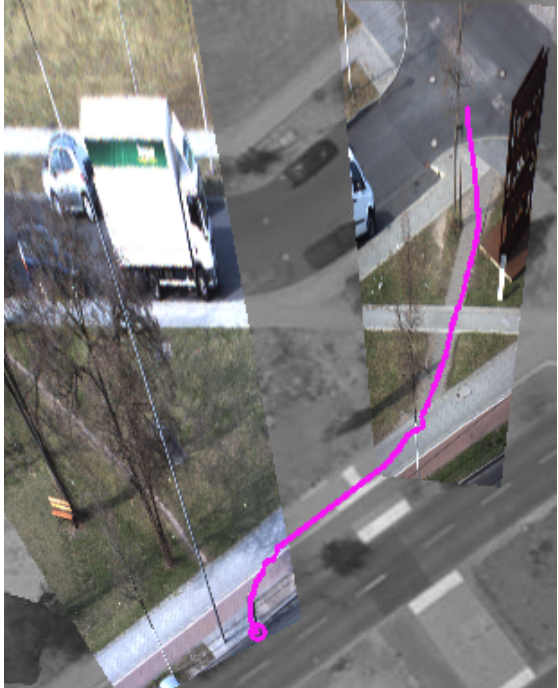
Figure 6: Example of a tracking in the reference coordinate sys- tem. Both camera images are transformed onto the ground plane. The ground plane is indicated with an aerial image of the